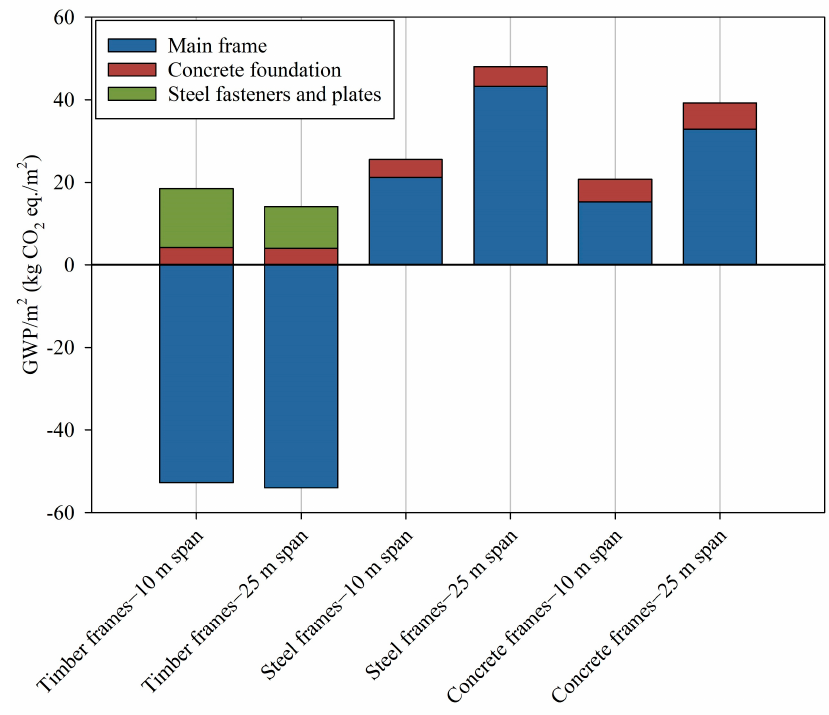
Figure 3. Comparison between the GWP/m 2 for all frames.